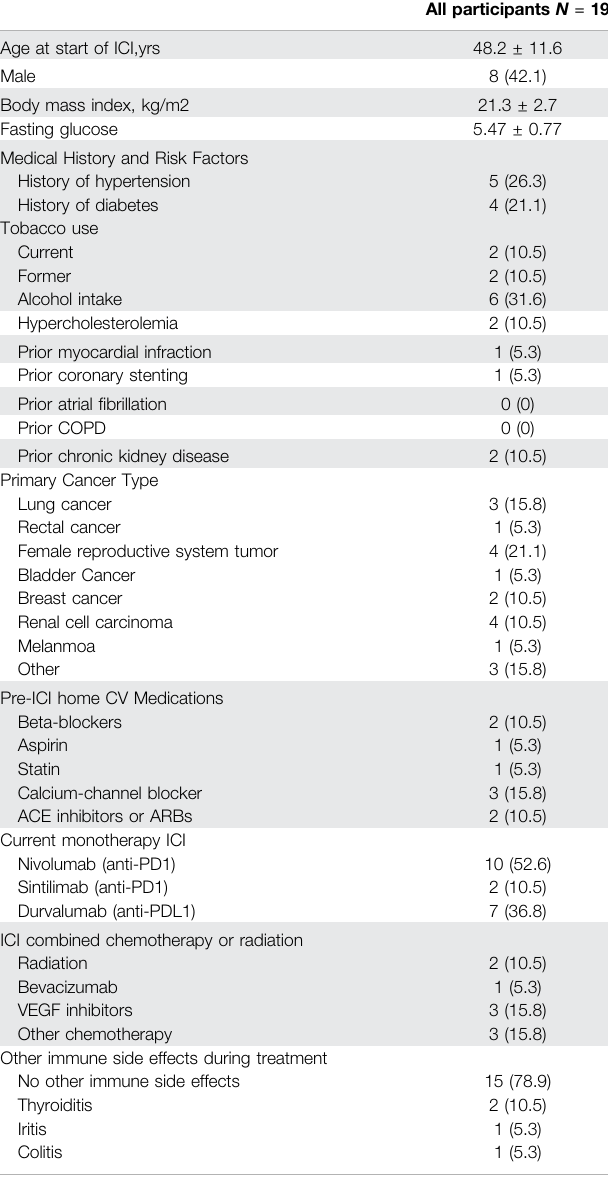
TABLE1 | Baseline Characteristics of study